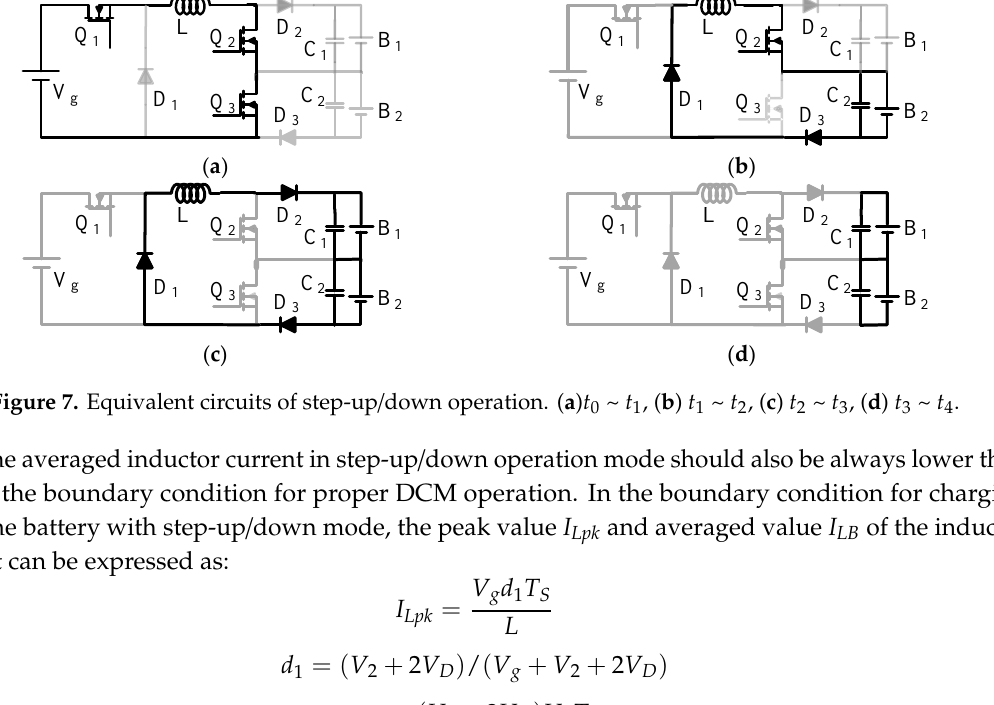
Figure 6. Waveforms of charging two batteries with different currents in step-up/down operation.